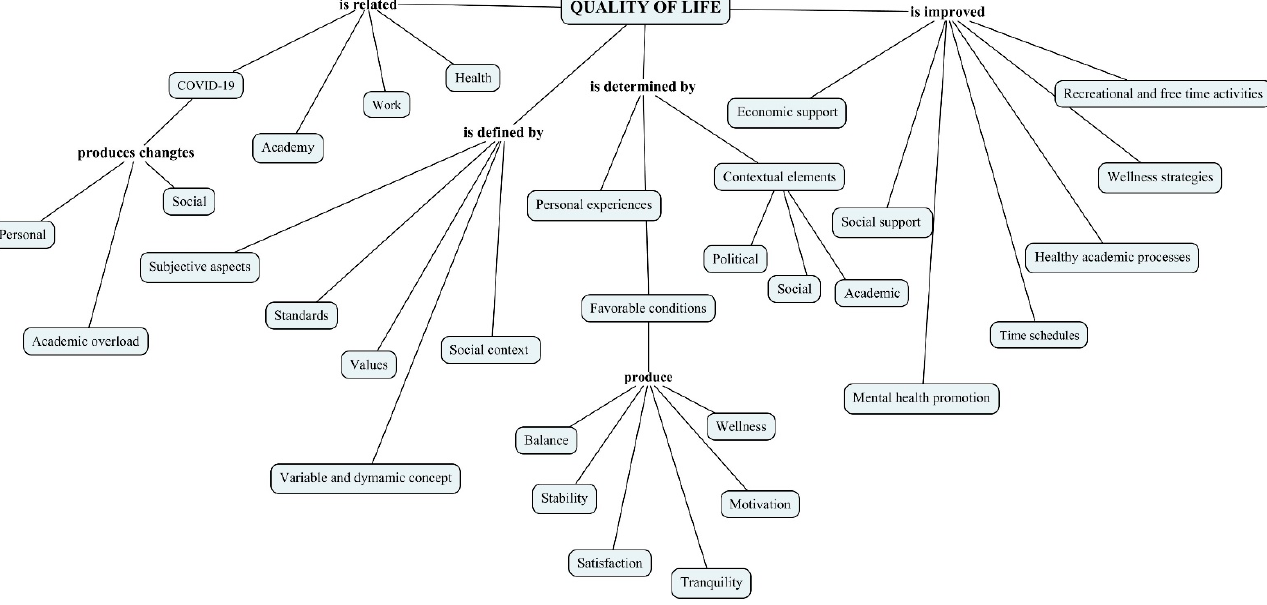
Figure 2. Conceptual map for “Quality of life: definitions, determinants, and satisfiers”. Elaborated by using Cmaptools 6.03.01.